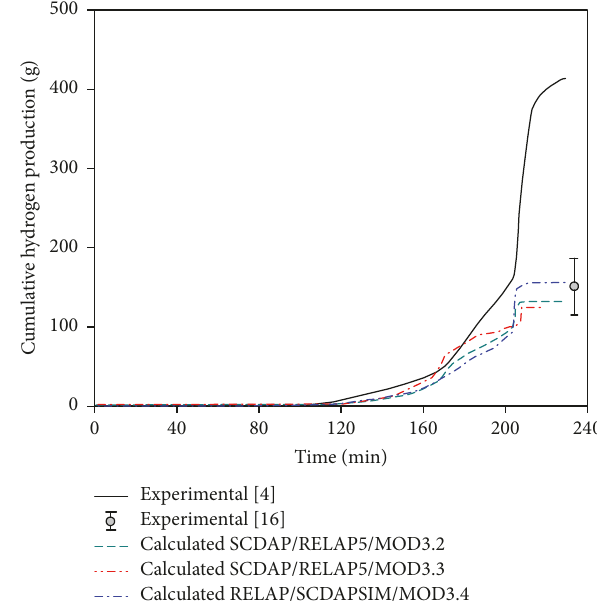
Figure 11: Comparison of cumulative hydrogen production mea- sured in the experiment and predicted by the